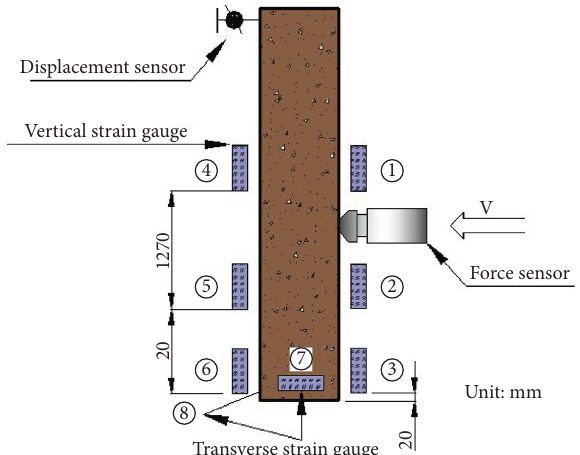
Figure 15: Positions of measuring points of the